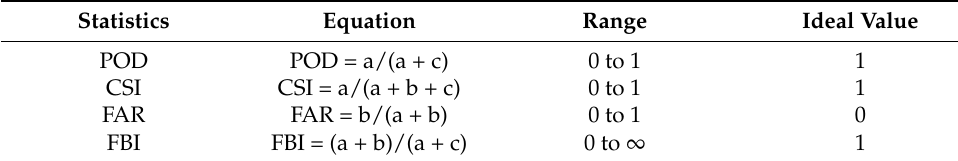
Table 3. Categorical validation statistics for rainfall detection